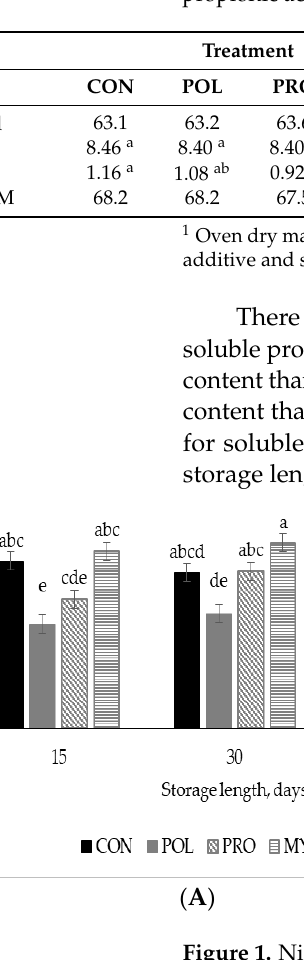
Table 2. Chemical composition of reconstituted corn grain ensiled for 15, 30 or 60 d, without additive treatment (CON), or treated with polysorbate 80 (POL), propionic acid (PRO) or polysorbate 80 and propionic acid (MYC).